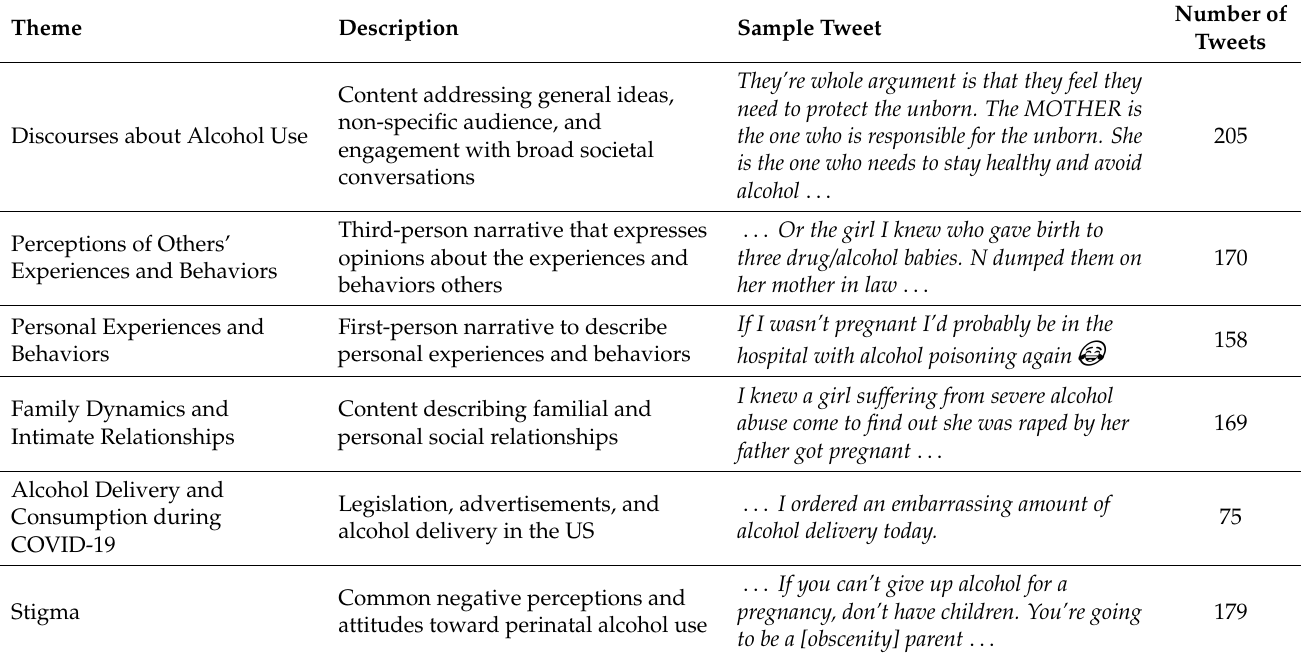
Table 1. Alcohol Use and Pregnancy Themes and